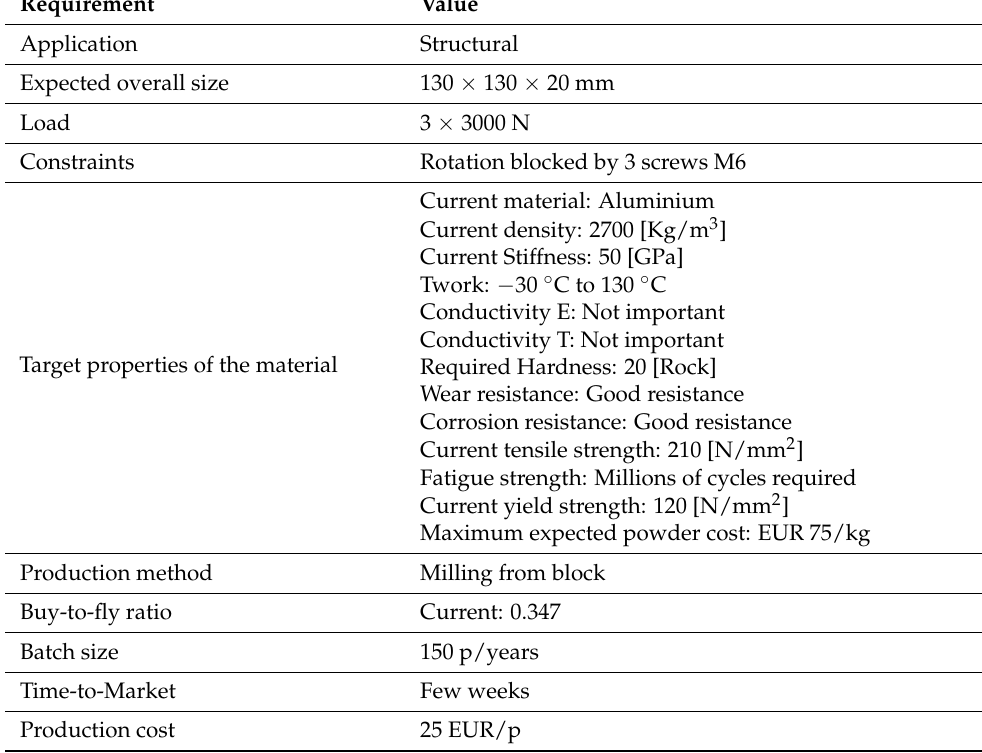
Table 7. Design requirements for the analysed